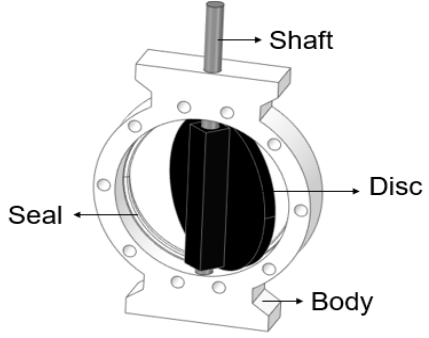
Figure 2. Structural of the butterfly valve.